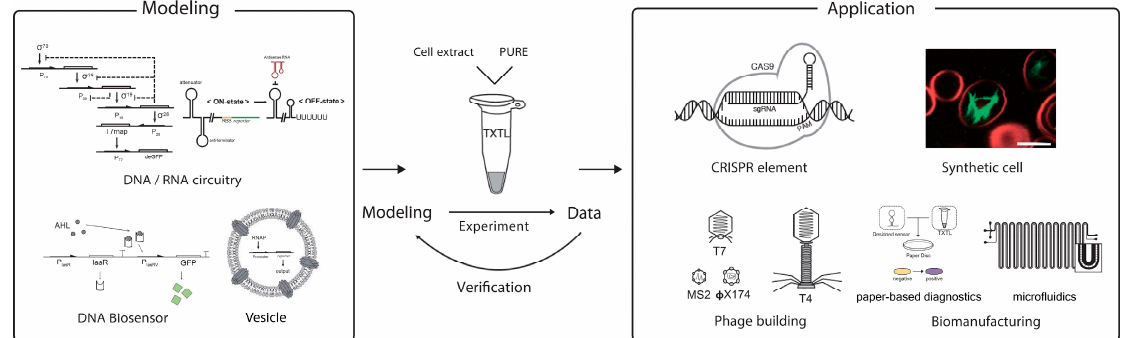
Figure 1. Overview of the cell-free transcription–translation platform. The cell-free transcription– translation platform including Escherichia coli cell-extract (TXTL) system and PURE system, allows for the prototyping of synthetic circuits rapidly through iterative cycles of experiments and computational modeling. TXTL has a number of applications, such as characterization of CRISPR elements or construction of synthetic cells. Reproduced with permission from [15,16].